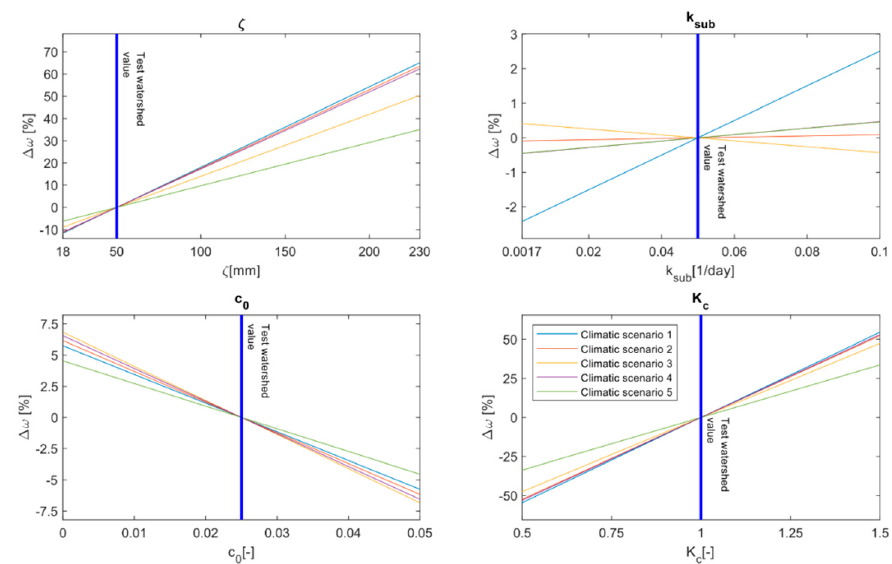
Figure 7. Sensitivity analysis on morphological and vegetation regression equations relating model parameters to 𝜔 , in different climates. Coefficients are reported in Table 3. The percentual alteration ∆𝜔 due to variation of each morphological and vegetation descriptors (ranging between minimum and maximum values reported in Table 2) from the configuration of test-watershed setting, is reported.